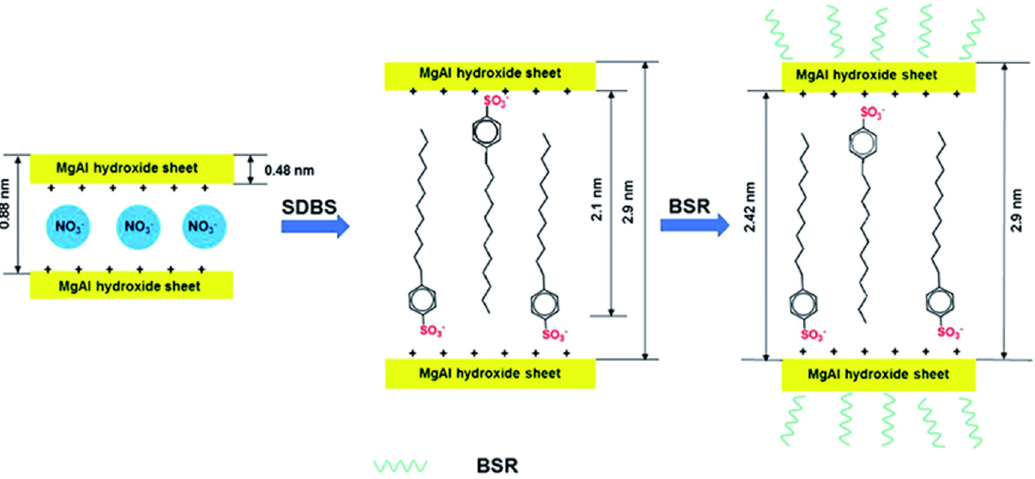
Figure 4. Schematic illustration of the preparation process of DBS-LDH/BSR [107]. Table 2. Inorganic flame retardants and their characteristics.